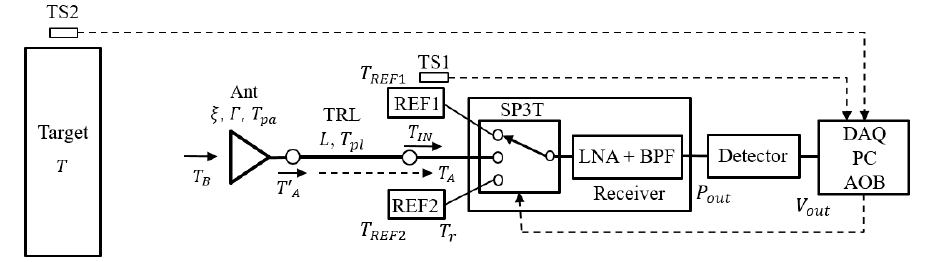
Figure 1. Designed total power radiometer with two reference loads.